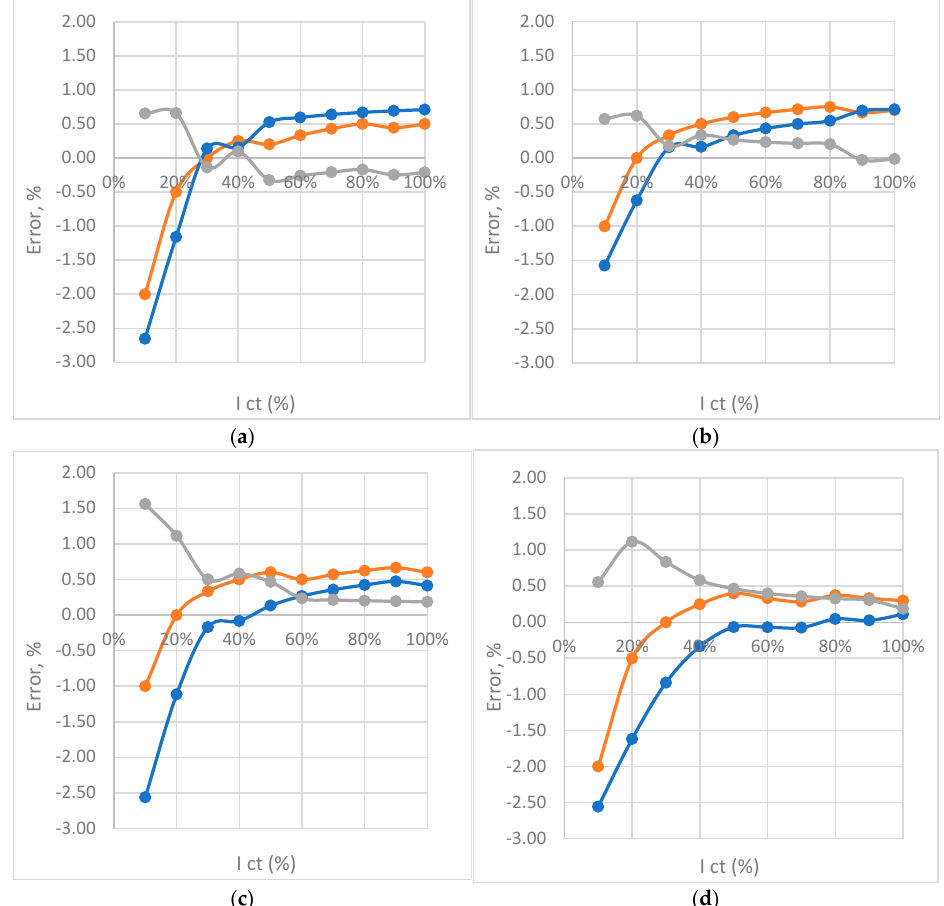
Figure 13. CT error curves depending on the secondary current for the frequency: ( a ) f = 50 Hz measured (red); function (blue); difference (gray). ( b ) f = 100 Hz measured (red); function (blue); difference (gray). ( c ) f = 150 Hz measured (red); function (blue); difference (gray). ( d ) f = 200 Hz measured (red); function (blue); difference (gray). Sensors 2023 , 23 , x FOR PEER REVIEW Figure 14 represents four curves of function error e f and measured error e m . Differ- ences between curves can be seen depending on frequency [8,9].